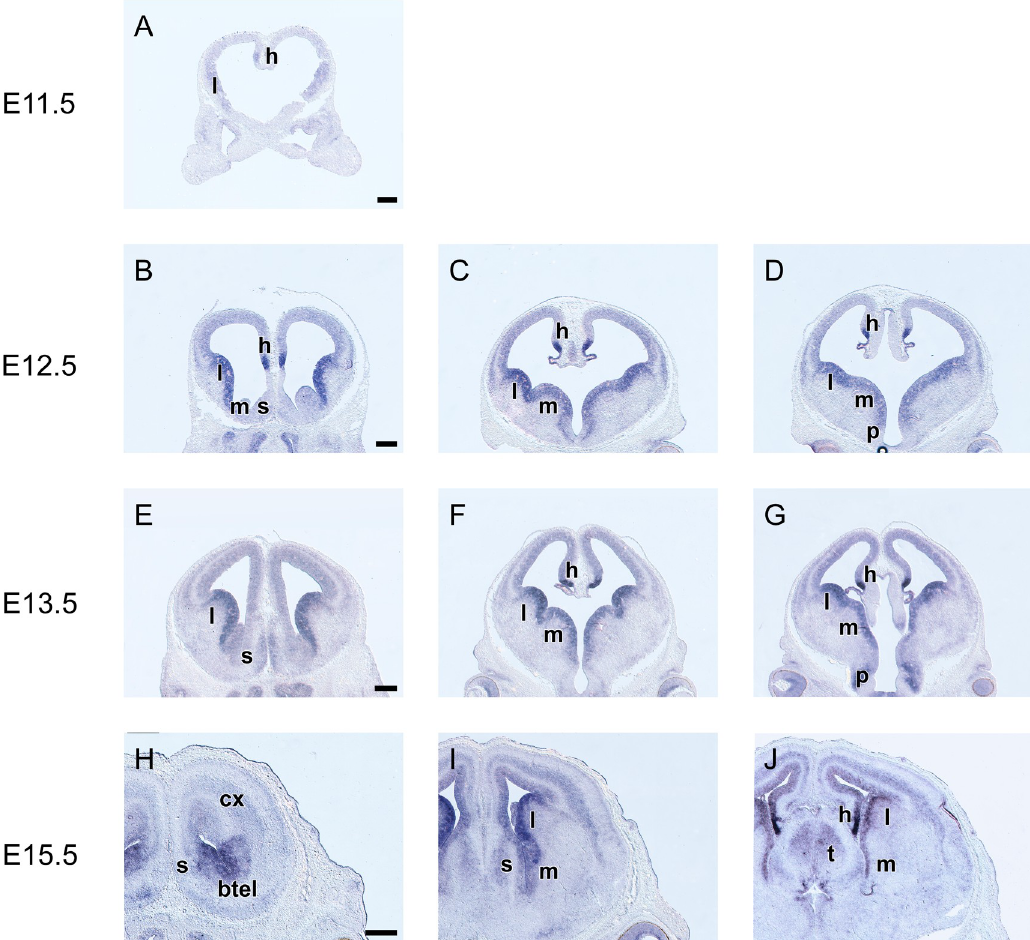
Fig 1. In situ hybridization on coronal sections through the embryonic telencephalon from rostral (left) to caudal (right) levels hybridized with an antisense RNA probe of Grg1 at E11.5 (A), E12.5 (B—D), E13.5 (E-I) and E15.5 (H—J) m: MGE, l: LGE, l: LGE, s: septum, btel: basal telencephalon, cx: cortex. Scale: 250 μ